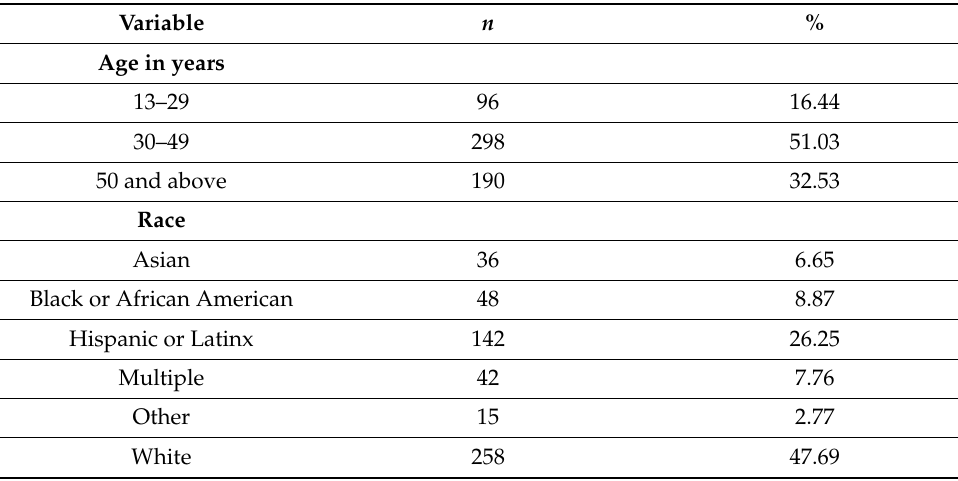
Table 1. Individual